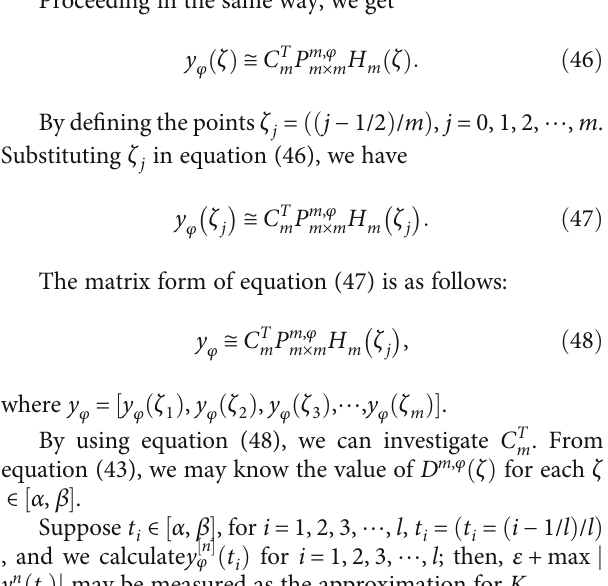
Table 3: Maximum absolute error for various choices of ρ and J